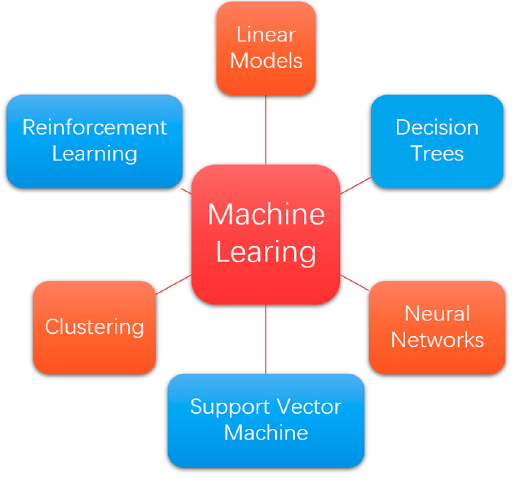
Figure 1. Commonly employed ML algorithms grouped in underlying mechanisms.